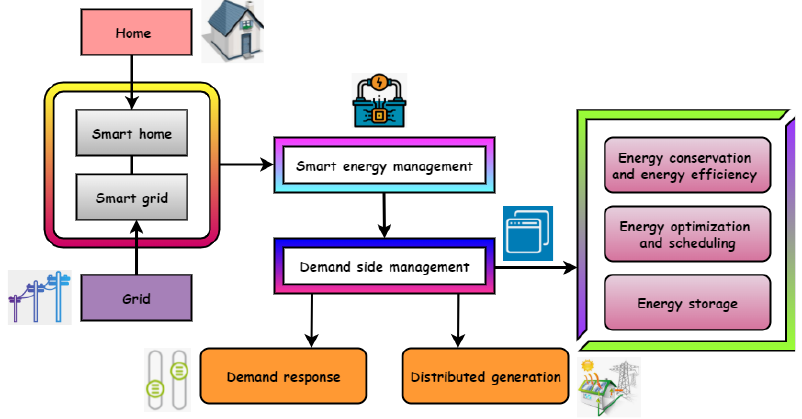
Figure 6. Design of smart energy management.